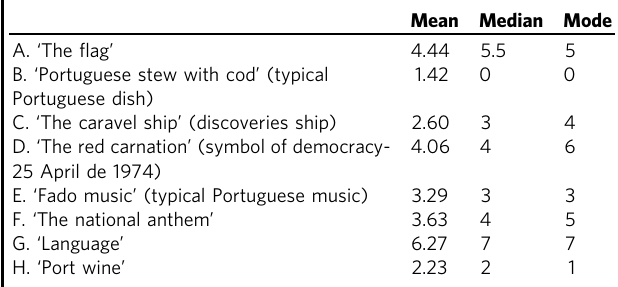
Table 7 Descriptive statistical measurements summary regarding to the question 4 ‘ The symbols that re fl ect my identity are …’